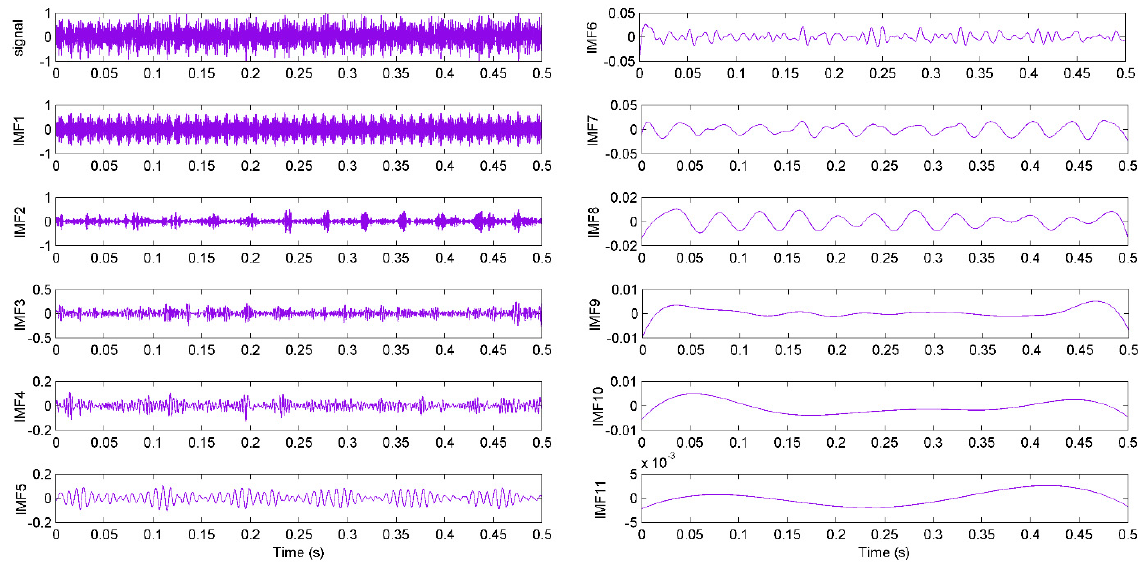
Figure 7. The decomposed components with EEMD and original signal from S1 at F3.